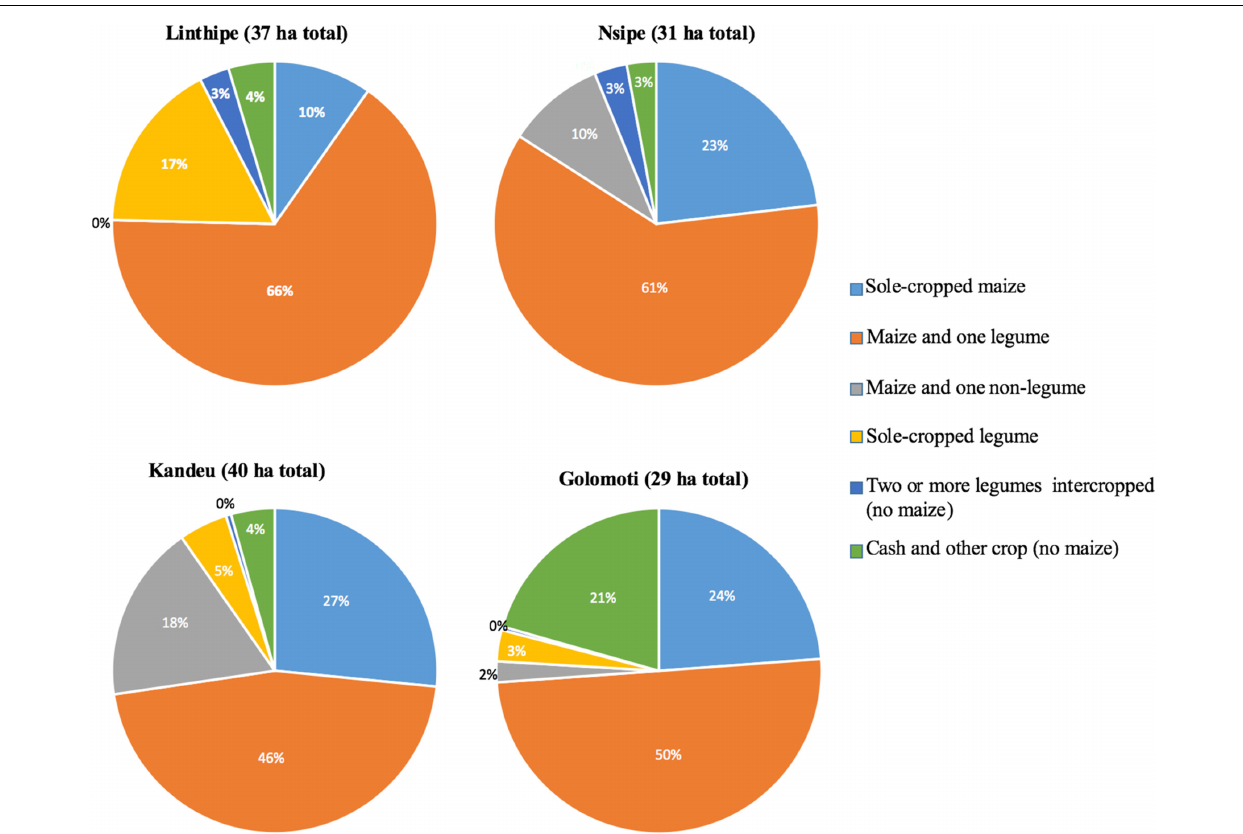
TABLE 5 | Farming system combinations grown at four sites in Central Malawi, percentage of farmers using the combination per site. Crops Golomoti (%) Kandeu (%) Nsipe (%) Linthipe (%) Maize (sole) 53 . 8 67 . 9 65 Maize + pigeonpea Maize + groundnut Maize + soybean Maize + cowpea ∗ Groundnut + soybean 0 Groundnut + common bean 0 Groundnut + cowpea